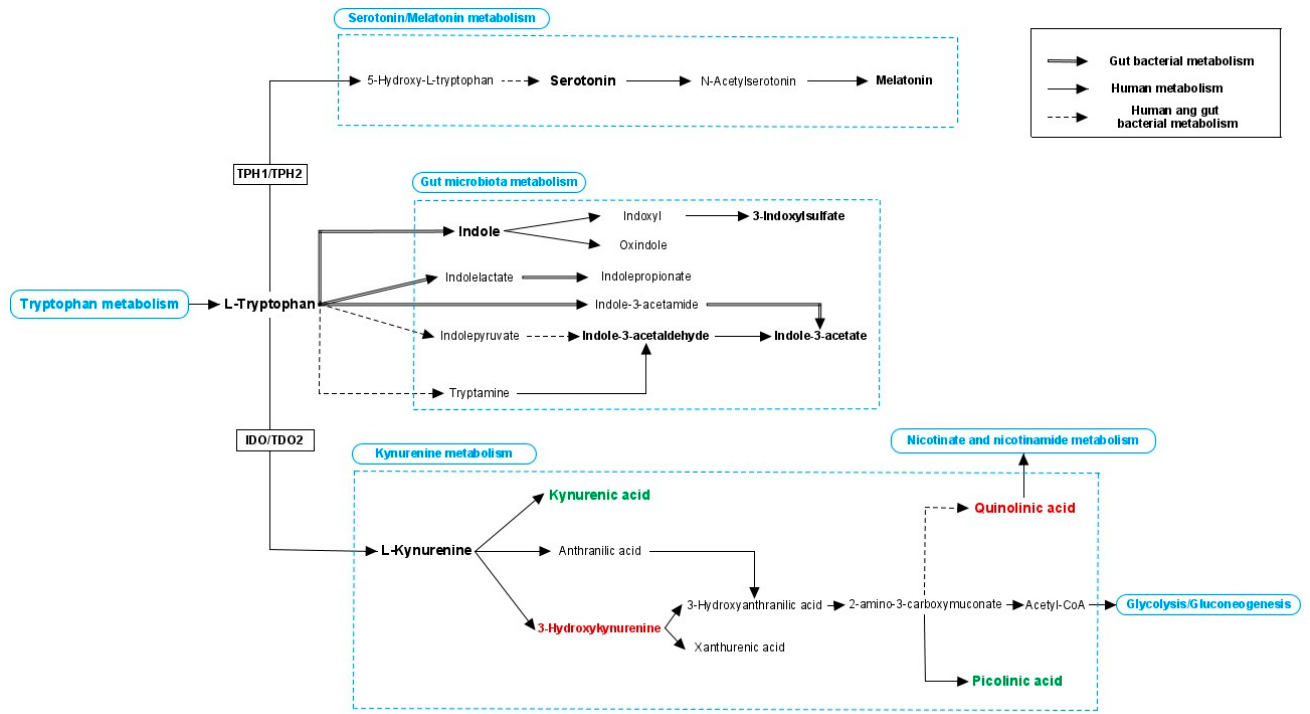
Figure 2. Tryptophan metabolism. Tryptophan can enter three different pathways: serotonin/melatonin pathway, gut microbial metabolism and kynurenine pathway. Tryptophan hydrolase 1 and 2 (TPH1 and TPH2, which are expressed in the intestine and brain respectively) enzymes are key regulators of serotonin production. Many indolic compounds are derived from bacterial metabolism but also human enzymes contribute to their production, and they showed to affect multiple processes of the host. Indoleamine-2,3-dioxygenase (IDO, expressed in different organs) and tryptophan-2,3-dioxygenase (TDO2, expressed specifically in the liver) control the first and rate-limiting step of the kynurenine metabolism.